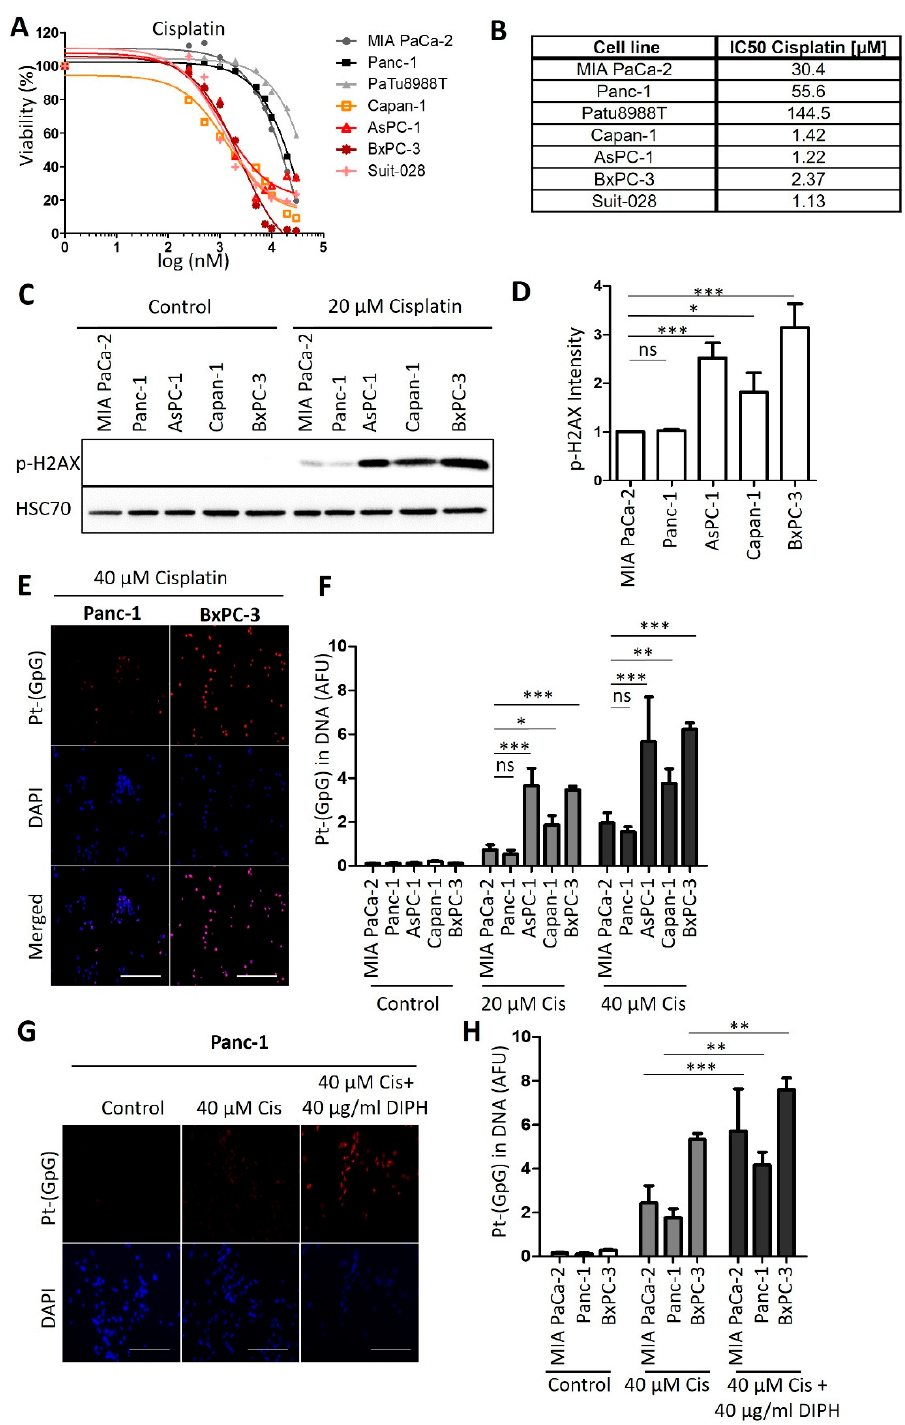
cells not only differ by platinum-induced cell killing, but also by the formation of platinated DNA in the first place and by the degree of platinum-induced DNA damage response.